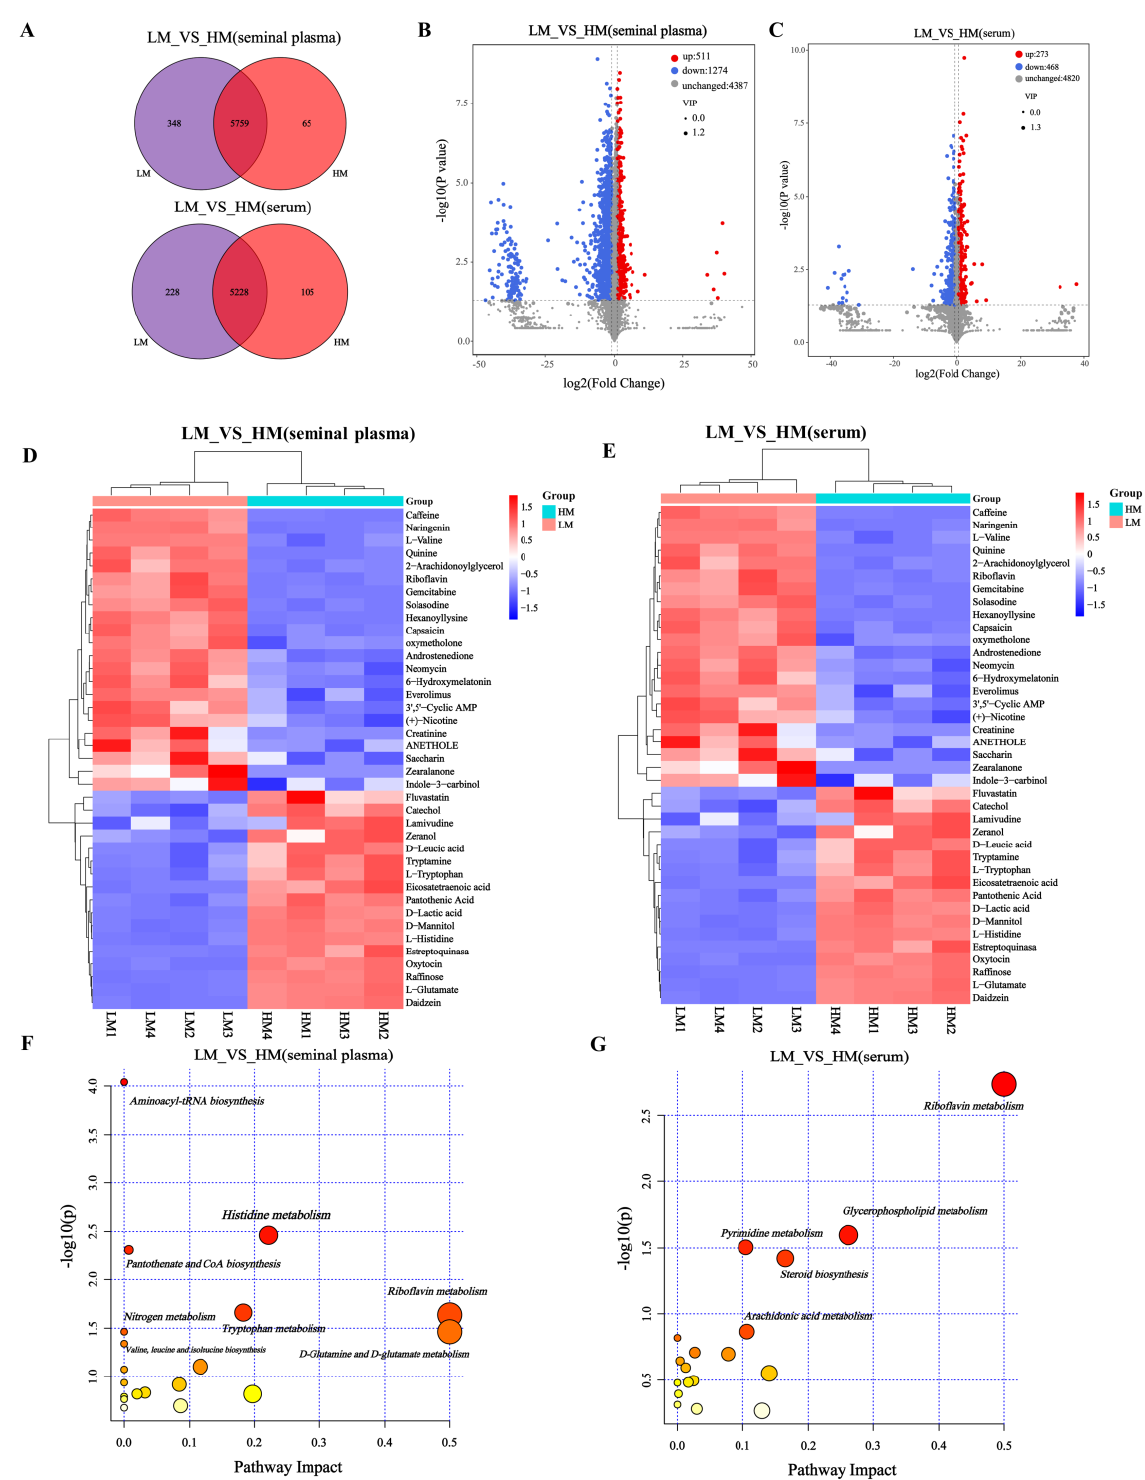
Figure 6. Identification of serum and seminal plasma metabolites and analysis of metabolic path- ways. ( A ) Venn diagram of seminal plasma and serum metabolites in LM and HM groups. ( B , C ) Volcano maps of metabolites in different groups of seminal plasma (FC = 2, p = 0.05, VIP = 1) and serum (FC = 1.5, p = 0.05, VIP = 1). ( D , E ) Heat maps of serum and seminal plasma differential me- tabolites between LM and HM groups. ( F , G ) Disturbed metabolic pathways in serum and seminal plasma samples of LM and HM groups were performed by MetaboAnalyst5.0. LM, low-motility group; HM, high-motility group.